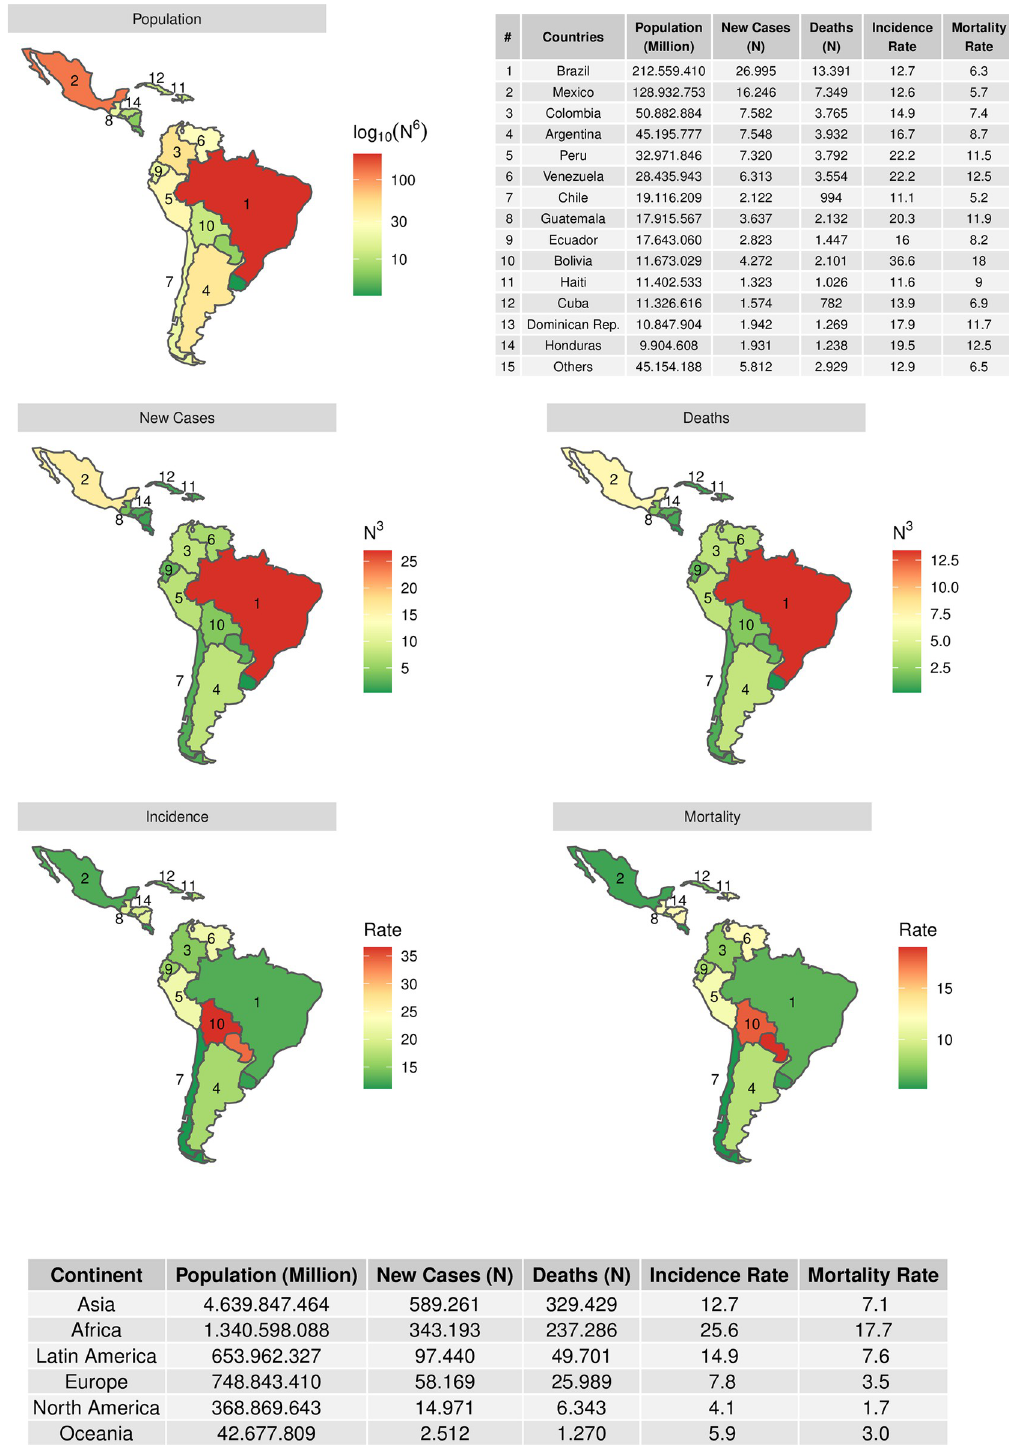
Fig 1. Estimated incidence and mortality rates in 2020 in females of all ages for the six continents, and the top 20 Latin America and the Caribbean. Data obtained from [1].